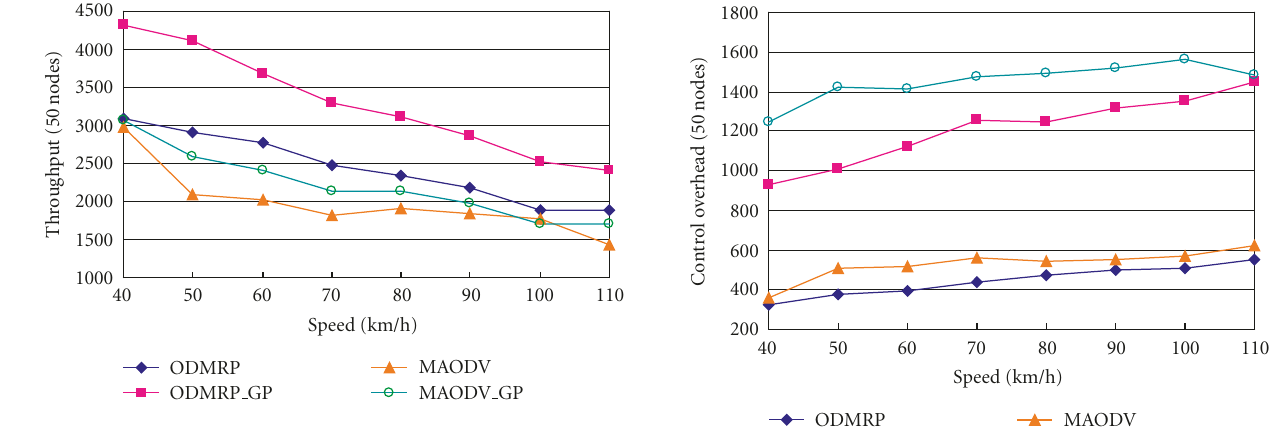
Figure 14: Throughput versus mobility speed (50 nodes).